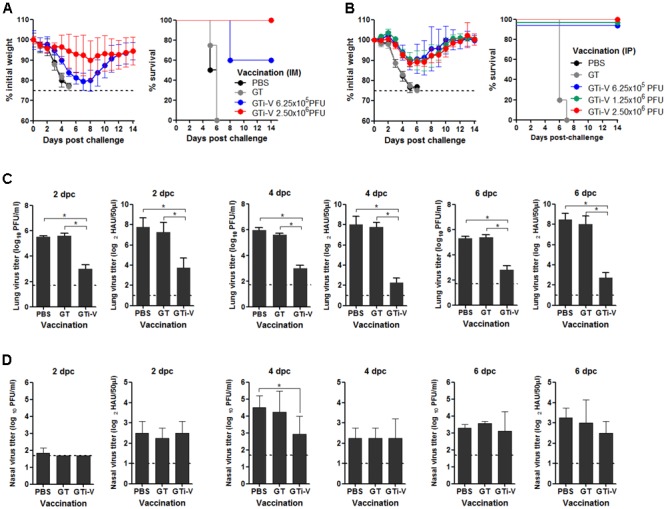
Protective efficacy of GTi influenza viruses. (A,B) Protection against lethal challenge with PR8 virus. Mice (n = 5) with IM (A) or IP (B) vaccination with different doses of GTi virus, and control mice given PBS were challenged with 10 MLD50 of PR8 virus at 4 weeks after boost vaccination. After the challenge, the weight changes and survival of the mice were monitored daily. Mice that lost their initial weights more than 25% were considered as non-viable and euthanized. (C,D) Challenge viral replication in the mouse respiratory tracts. Separate groups of mice (n = 4) were primed and boosted with 2.5 × 106 PFU of GTi virus via IP route, and control mice were inoculated with PBS or GT. Four weeks later, the mice were challenged with 10 MLD50 of PR8 virus, and the lung and nasal turbinate were taken at 2, 4, or 6 days post-challenge for viral titration. The viral PFU titers and HAU titers in the lungs (C) and nasal turbinate (D) are shown. Dashed lines indicate the detection limits of the assay. ∗P < 0.05 when comparing two different groups.